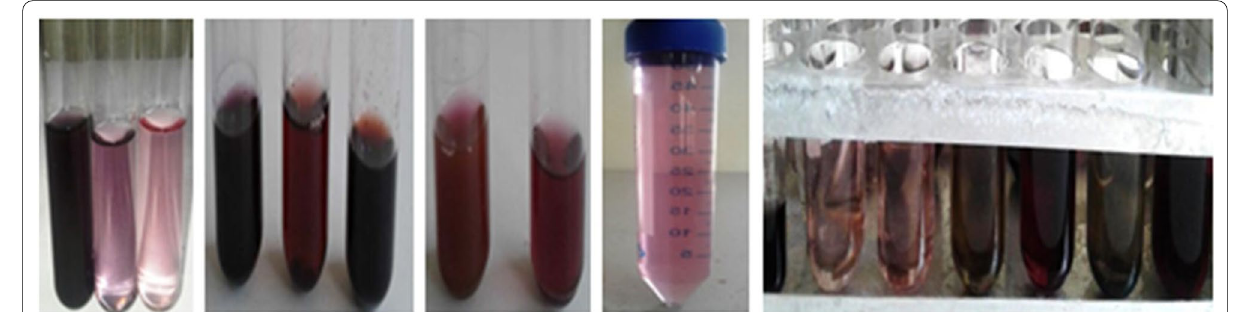
Fig. 4 Synthesized nanoparticles showing varying intensity of color